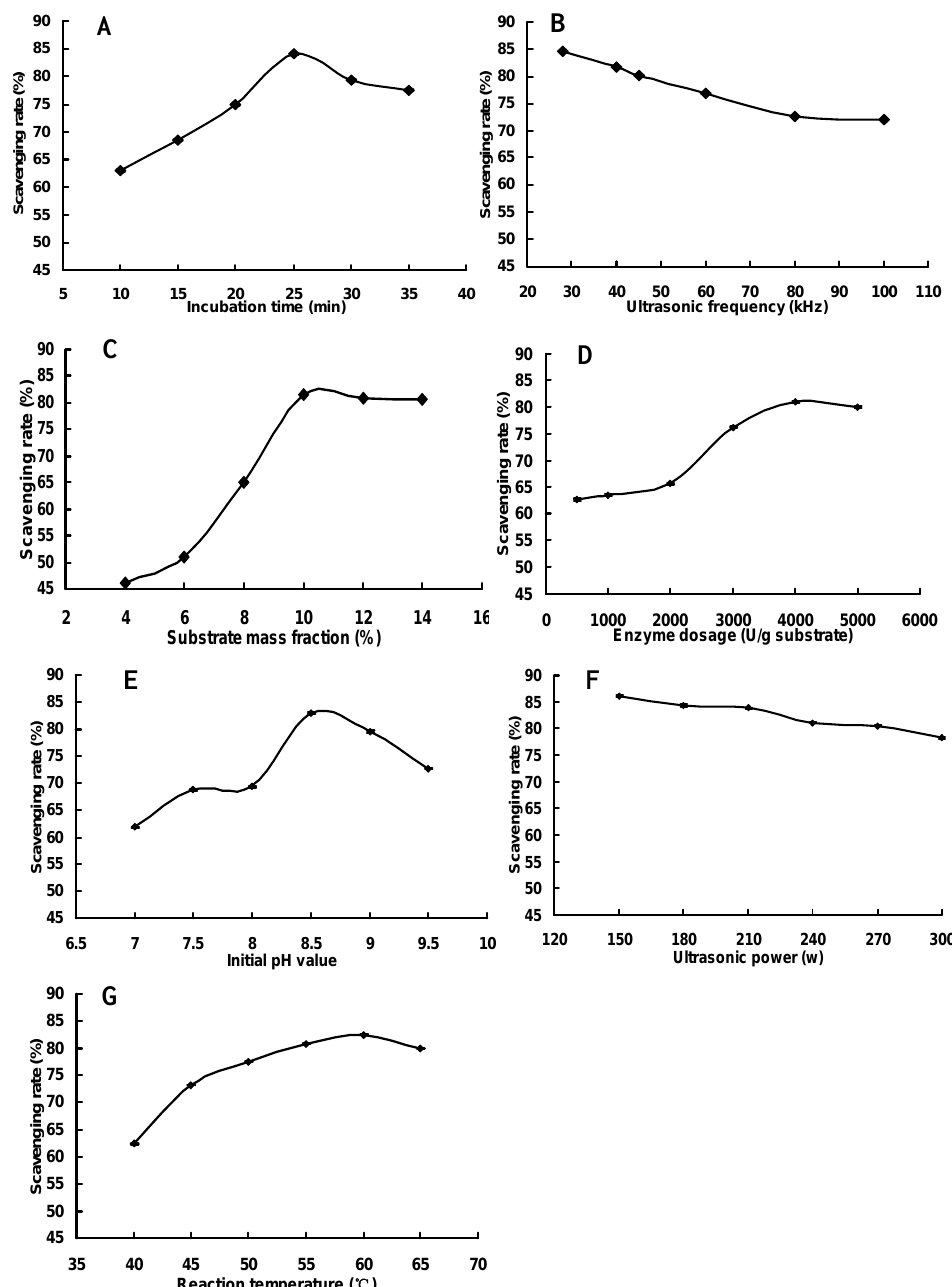
Figure 1. Effects of incubation time ( A ), ultrasonic frequency ( B ), substrate mass